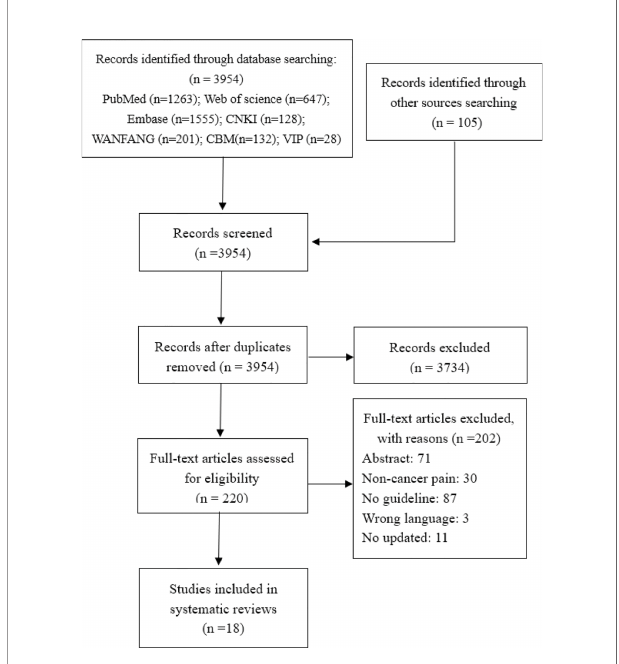
FIGURE 1 | PRISMA fl ow diagram of study selection